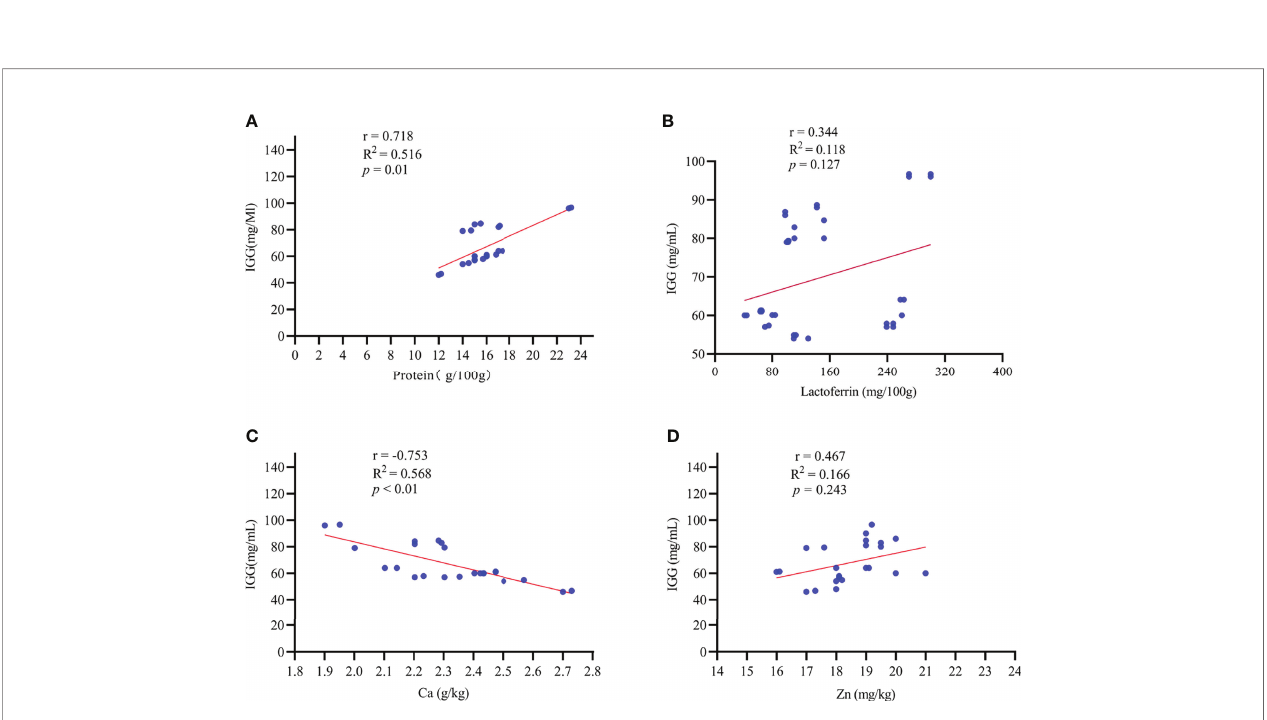
FIGURE 4 | The correlation between colostrum IgG content and colostrum composition. r: Pearson correlation coef fi cient. Effects were considered signi fi cant at p < 0.05, whereas a tendency was assumed for 0.05 ≤ p ≤ 0.10. n = 35. IGG, immunoglobulin G; Ca, calcium; Zn, Zinc. (A – D) : the correlation of macro-element and trace element with IgG concentration in